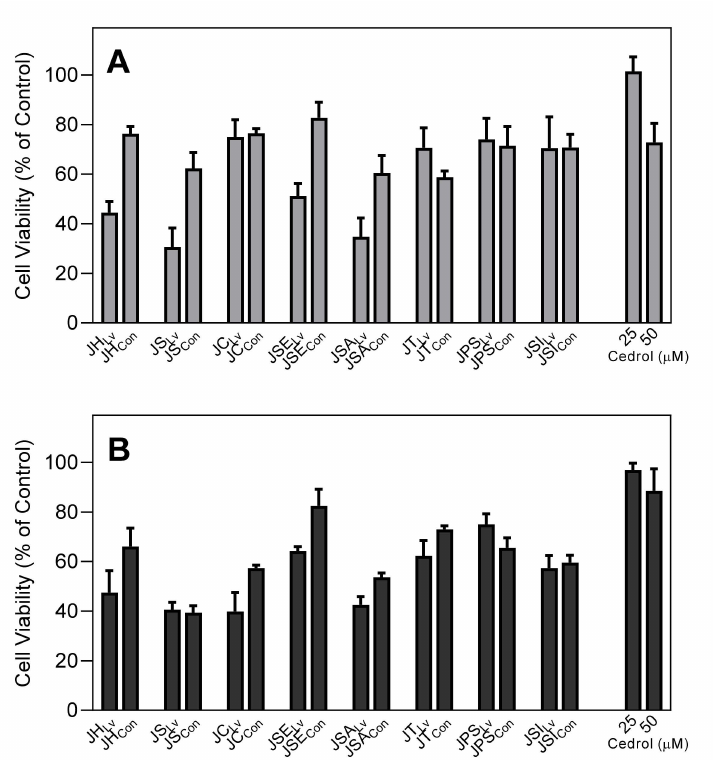
Figure 5. Cytotoxicity of Juniperus essential oils and cedrol. HL60 cells were preincubated with 25 µ g/mL of Juniper oil or 25 and 50 µ M of pure (+)-cedrol for 30 min ( A ) and 90 min ( B ) and cell viability was analyzed, as described. Values are the mean ± SD of triplicate samples from one experiment that is representative of two independent experiments with similar